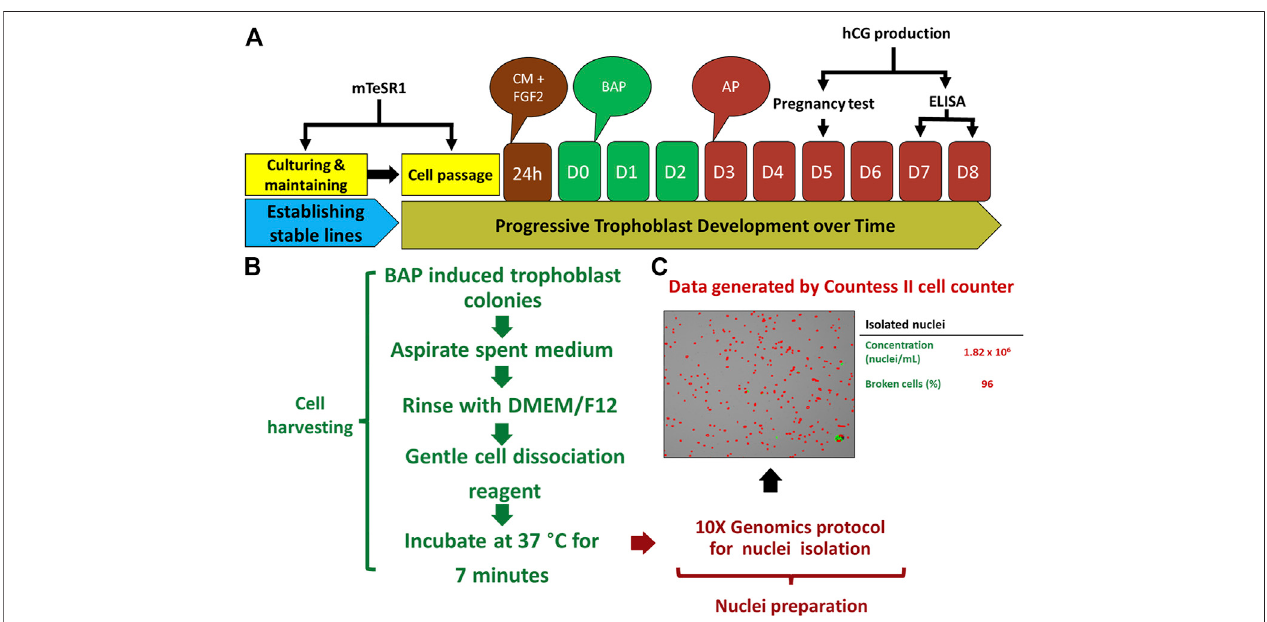
FIGURE 2 | Protocol for TB development and nuclei isolation. (A) Strategy for BAP directed trophoblast development. Human embryonic stem cells (hESCs) thawed and passaged several times on mTeSR1 medium to established stable lines. The day following passaging, mTeSR1 medium was replaced with FGF2 (4 ng/ μ L) supplemented conditioned medium (mouse embryonic fi broblast (MEF)-conditioned DMEM/F12 with knockout serum replacement (KOSR) medium). For trophoblast (TB) induction, after 24 h, the cells were kept on DMEM/F12/KOSR (BAP/DMEM/F12/KOSR) medium supplemented with BMP4 (10 ng/ml), A83-01 (1 μ M), and PD173074(0.1 μ M)for3 days(BAPtreatment),andthesamemediumwithoutBMP4(APtreatment)tillday8. (B) Strategyusedfornucleiisolation.TBcellcolonieswere harvested by gentle cell dissociation reagent (GDR) (STEMCELL Technology, Cat# 07174) and were proceeded for nuclei isolation after 7 min of incubation at 37 ° C withoutaspiratingGDR. (C) Representativedatafromoneofisolatednucleisamples,leftpanelistheimageshowingisolatednuclei,rightpanelshowedconcentrationof the nuclei and percentage of the broken cells from which the nuclei were collected. Reproduced with permission from Khan et al. (Khan et al., 2021). BMP4, Bone morphogenic protein-4; A, A83-01 (Activin/Nodal inhibitor); P, PD173074; BAP, BMP4 + A83-01 + PD173074; AP, A83-01 + PD173074; hCG, human chorionic gonadotropin; D,